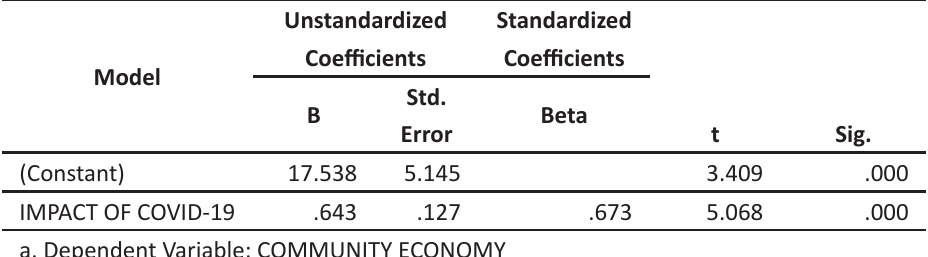
Table 7: Simple Regression